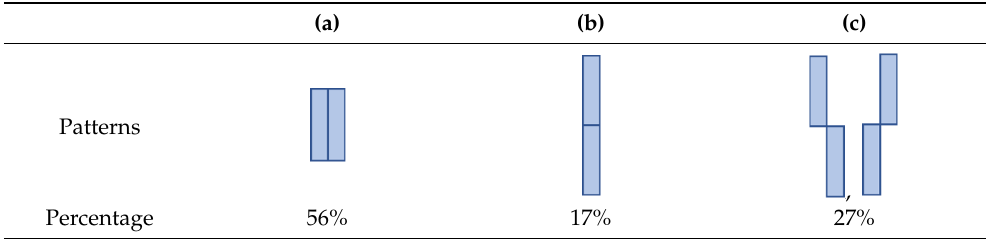
Table 1. Ratios of different patterns of two-bit MCUs.